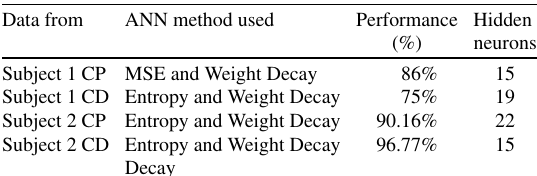
Table 1 Performance of the best classifiers on the data of two subjects. Note the different number of neurons in the hidden layer of the net, and the different position of the electrodes Data